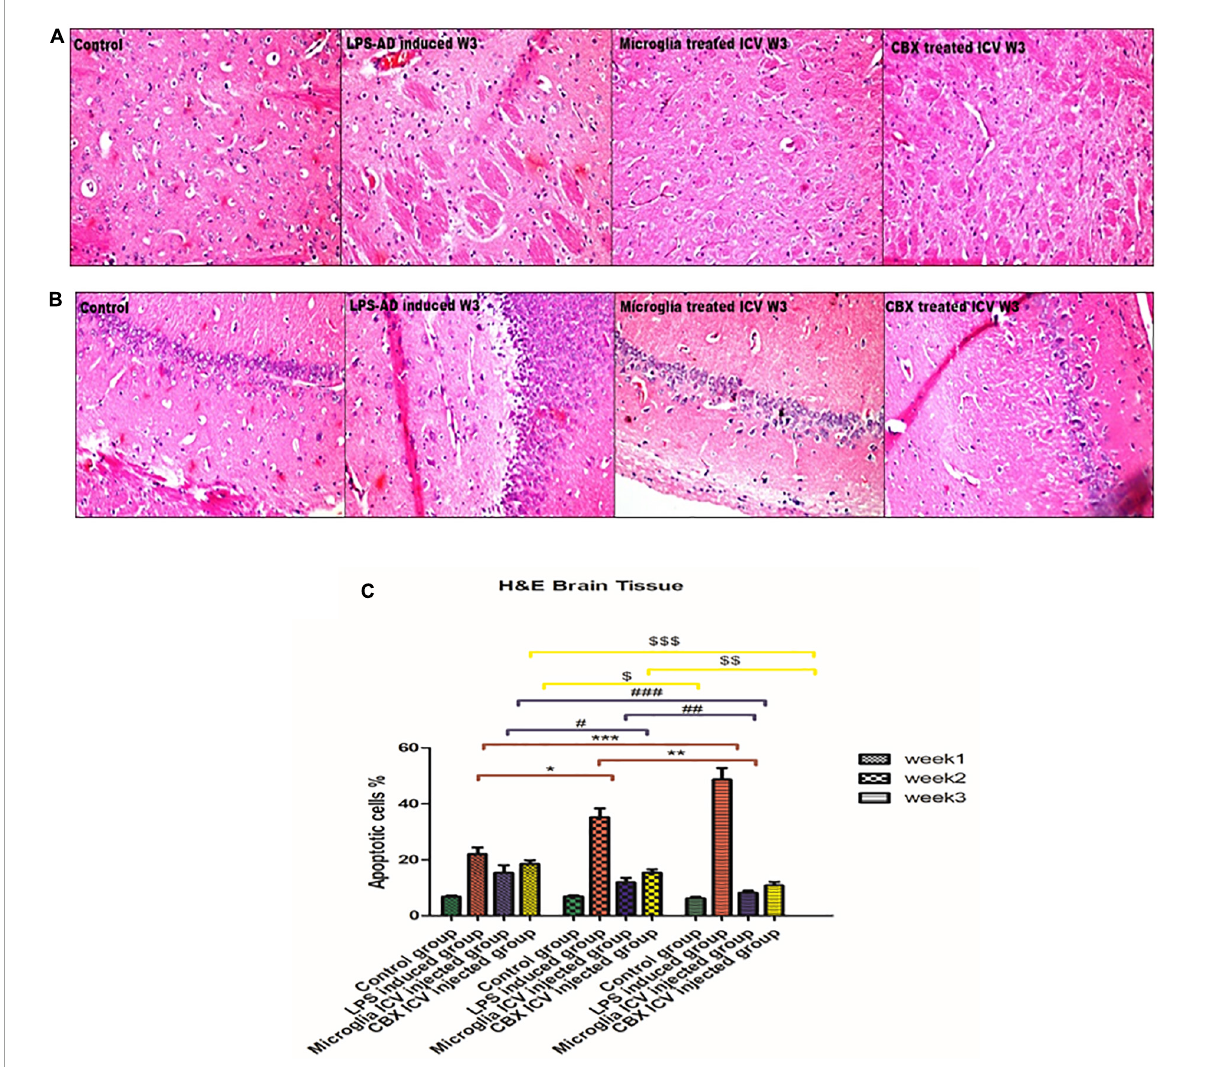
FIGURE7 Histopathological examination and assessment of the cerebral cortex and hippocampus stained H&E sections of the lipopolysaccharide (LPS)-induced rats and following the single intracerebroventricular (ICV) administration of primary healthy microglia (PHM) and carbenoxolone (CBX) (week 3). (A,B) Detection of the cerebral cortex and hippocampus H&E-stained sections in the control, LPS-induced group, PHM-treated group, and CBX-treated group (week 3). (C) Percentage of apoptotic cells histogram over the 3-week time interval. Represented data were expressed as mean ± SD ( n = 6 per group) (ANOVA, repeated measurement, Bonferroni post-hoc test, p < 0.05). The same asterisks represent an insignificant difference p > 0.05.